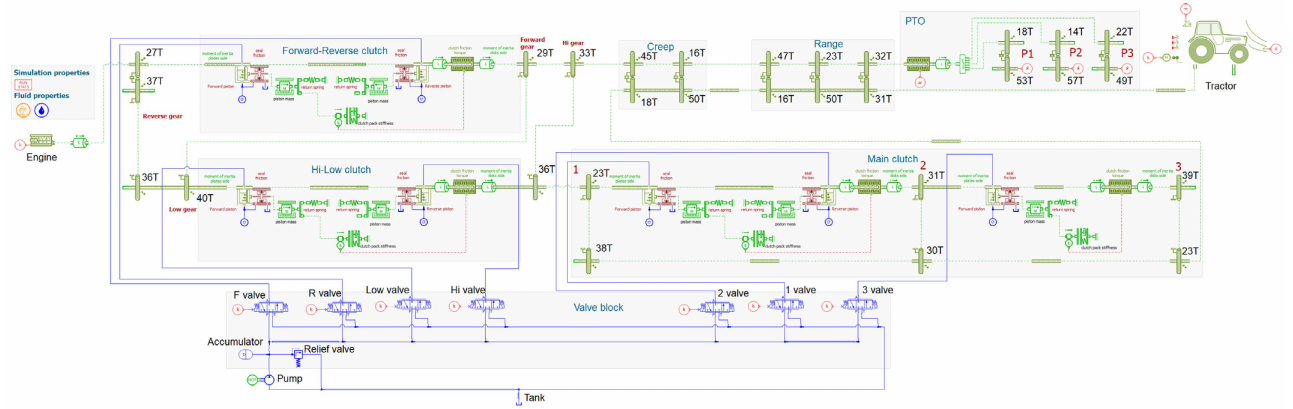
Figure 2. The simulation model of a 95-kW partial PST tractor.